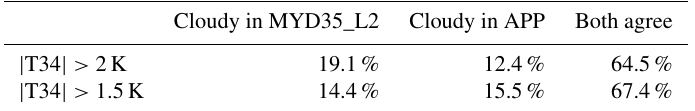
Table A1. For all years from 2002 to 2018, between 1 July and 31 October (dates of winter for polynya detection in this paper), median percentage of pixels that are cloudy according to the reference cloud mask MYD35_L2 but were not detected by the criteria applied to APP (first column); that are clear in the reference, but were incorrectly detected as cloudy in APP (second column); that are detected in both products as clear or cloudy (third column). The first line is when the original Yamanouchi et al. (1987) criterion | T34 | > 2K is applied; the second line is when it is modified as explained in this Appendix.